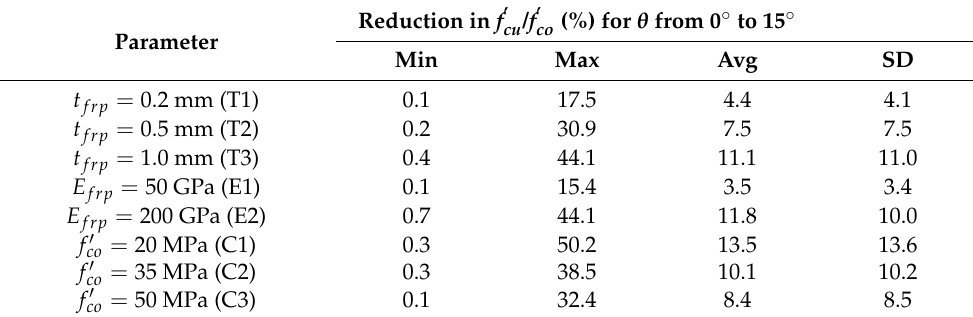
Table 5. Reduction in f (cid:48) cu / f (cid:48) co due to deviation in fiber orientation for different values of E frp , t frp and f (cid:48) co .